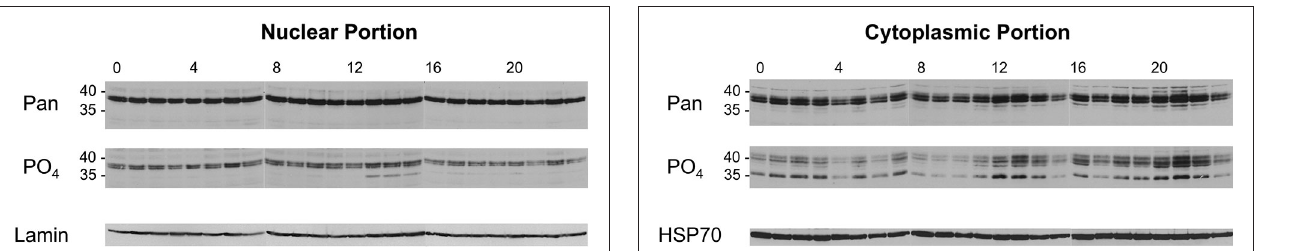
FIGURE 5 | Levels of nuclear dCREB2 protein isoforms oscillate through the day/night. Representative Western blot images of nuclear dCREB2 isoform oscillation within a 24 h period. Wild-type animals were entrained to a 12-12 light-dark schedule and flies were collected at the beginning of each hour throughout the day. Heads were isolated and then separated into nuclear and cytoplasmic fractions for subsequent analysis using SDS-PAGE and Western blot. Each set of samples was probed with an α -Pan (top) and α -PO 4 (middle) antibody to assess localization of dCREB2 isoforms across the day. Blots were probed with Lamin (bottom) as a loading control.